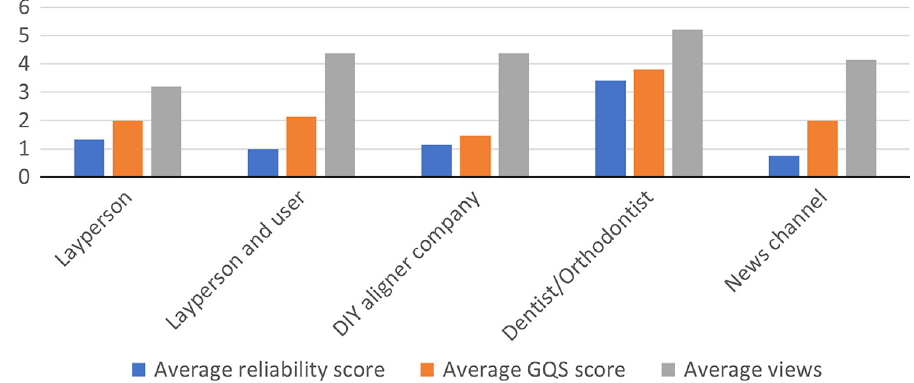
Figure 2. Reliability and GQS vs. sentiment.